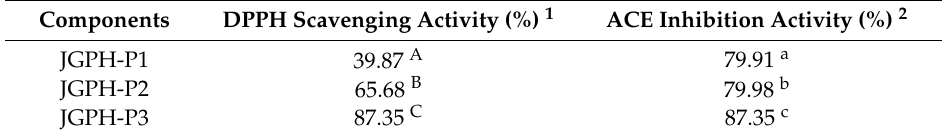
Table 2. DPPH radical scavenging activity and ACE inhibitory activity of JGPH (-P1, -P2, -P3).